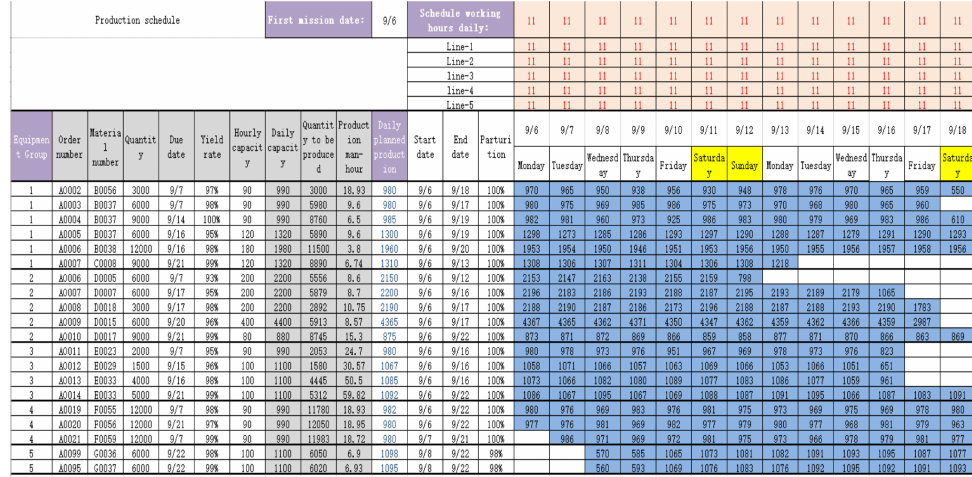
Figure 10. MEC scheduling